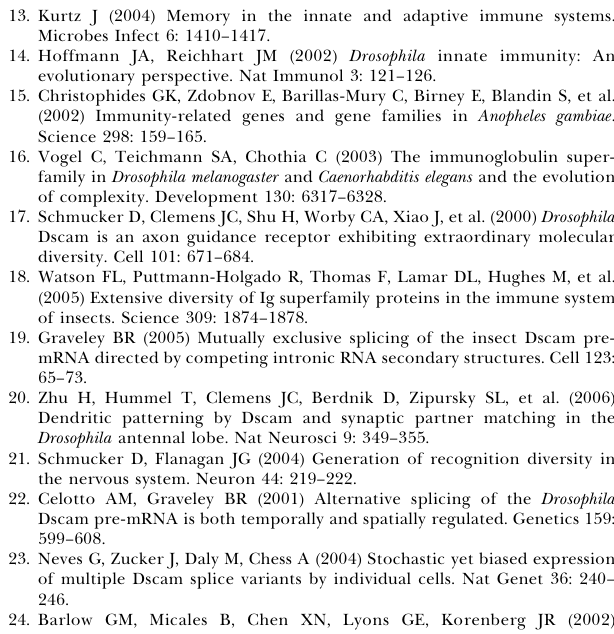
Figure S3. Kaplan-Meier Survival Analysis of AgDscam dsRNA -Treated Mosquito Survival Probability after Challenge with S. aureus and E. coli Compared to Control GFP dsRNA -Treated (GFP) Mosquitoes